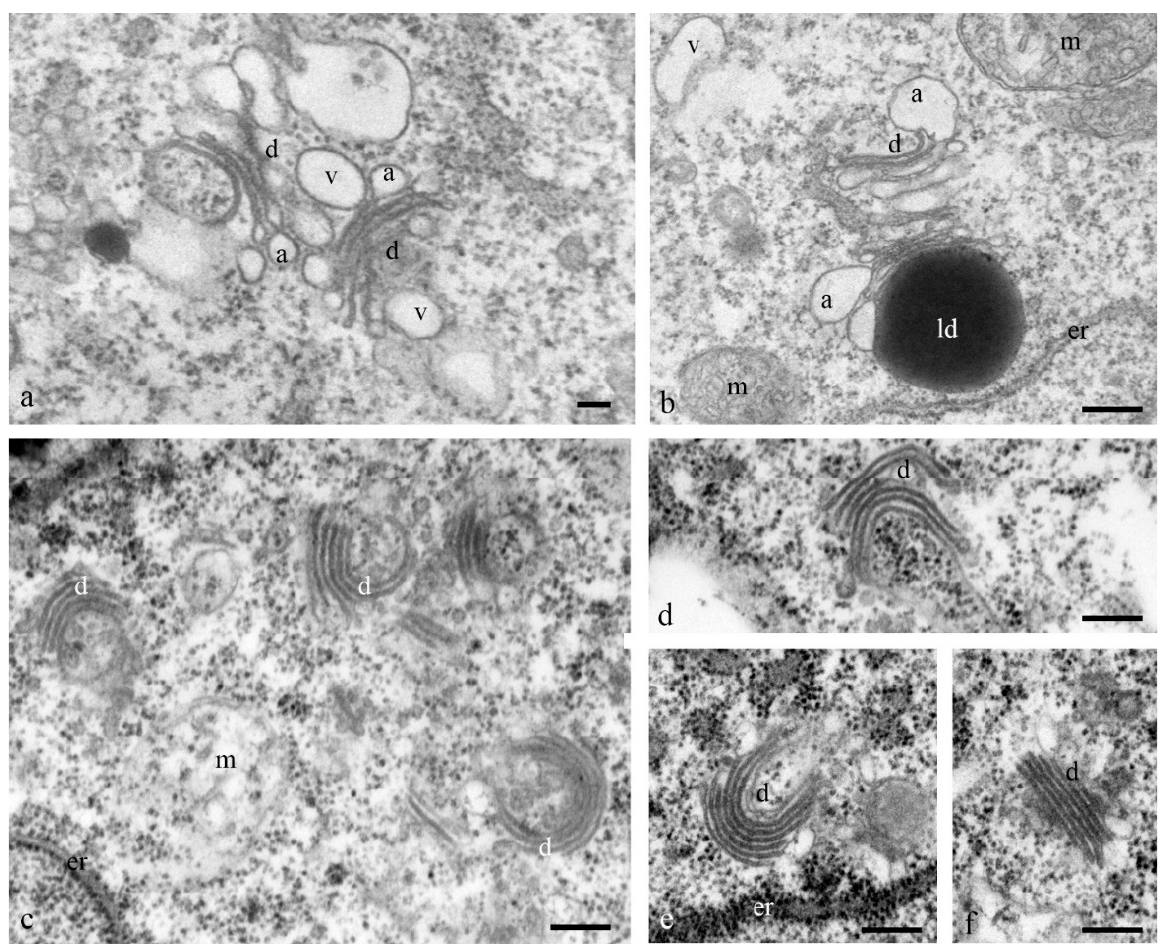
Figure 8. Ultrastructure of the Golgi apparatus in the cytoplasm of the antipodal cells. At the early stage of differentiation, individual dictyosomes consist of 5–7 flat cisternae with expanded ampoules ( a , b ). During programmed cell death, the stacks of dictyosome cisterns are bent ( c – f ). d—dictyosomes. a—ampoules of cisternae, er—granular reticulum; m—mitochondria; v—vacuoles. The scale is 100 nm.